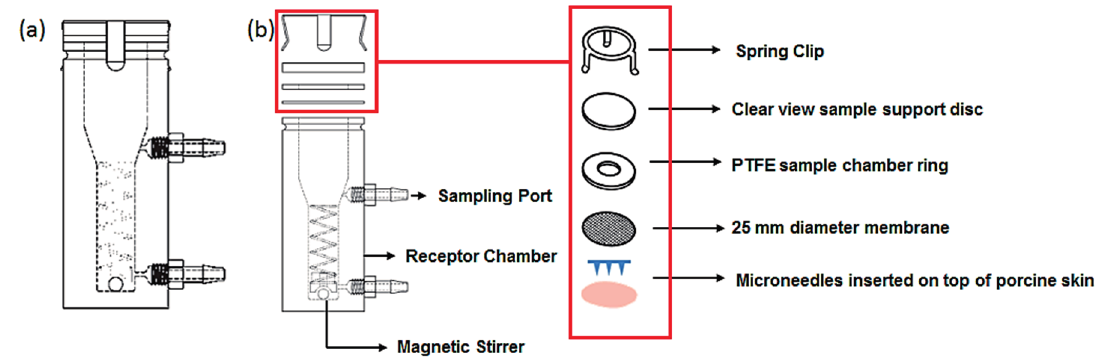
Figure 3. Schematic of the Franz diffusion experimental setup: ( a ) vertical diffusion cell; ( b ) exploded view of the cell and sample holder (adapted from